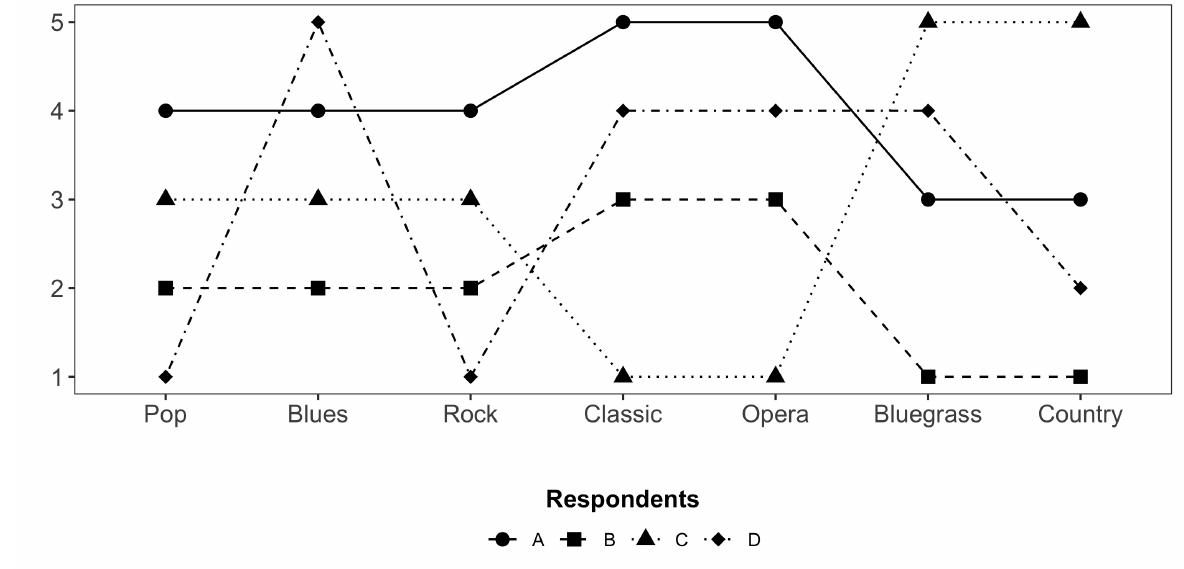
Figure 1: Hypothetical survey responses for four respondents. Note : Adapted from Goldberg (2011:1405) and Boutyline (2017:357, 361). The figure shows survey responses are musical tastes from four hypothetical respondents, ranging from “strongly dislike” (1) to “strongly like”